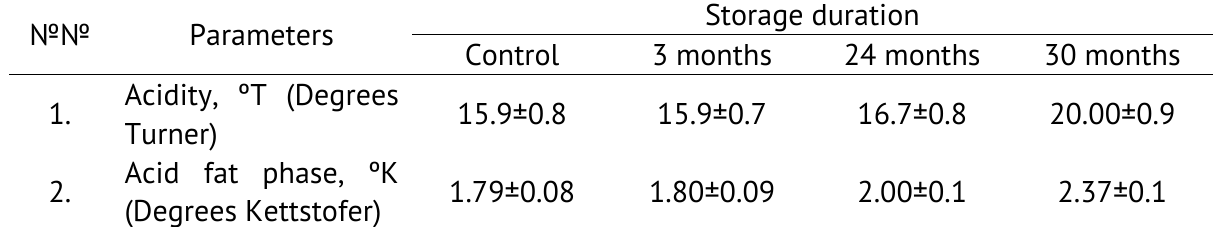
Biochemical parameters of butter after long-term storage  14 